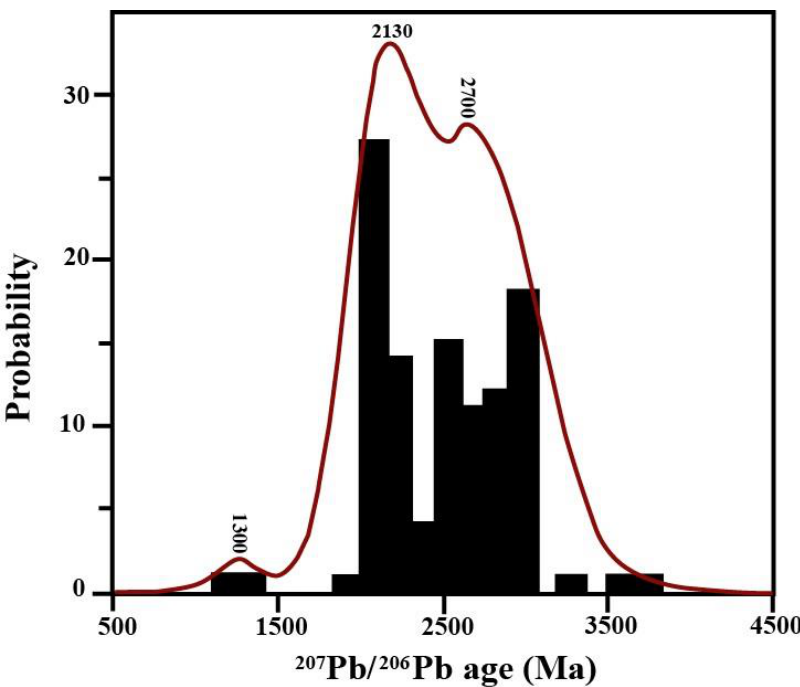
Figure 6. U-Pb discordia diagram for the southern Meiganga detrital zircons.